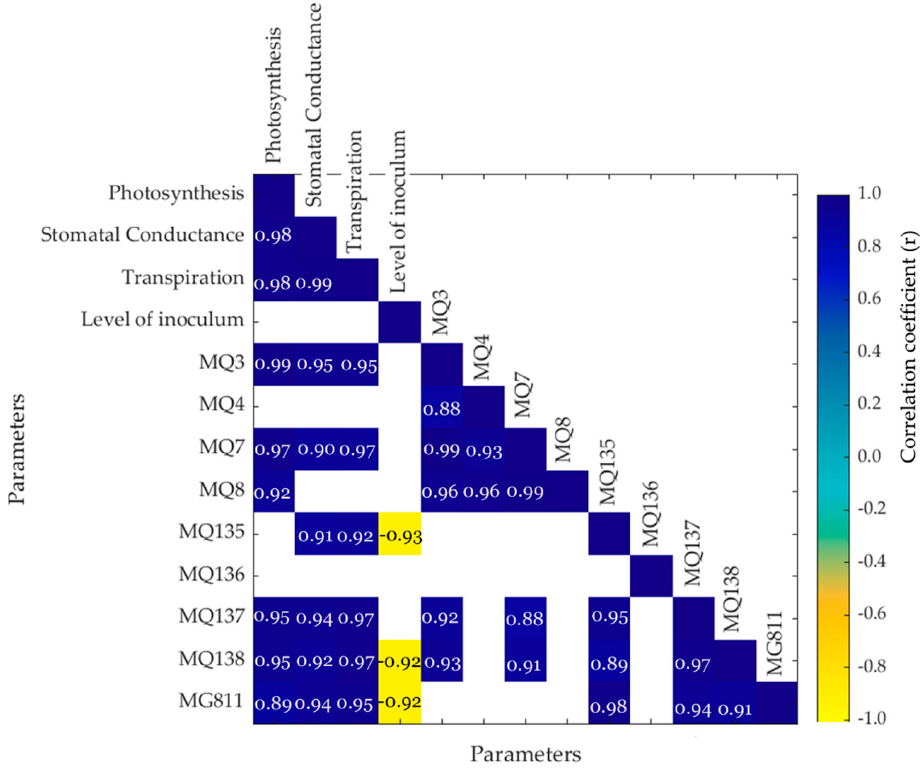
Figure 5. Matrix showing the significant correlations ( p < 0.05) between the physiological data, level of pathogen inoculum, and the electronic nose sensors. The color bar represents the negative (yellow) to positive (blue) correlations, and the numbers within each box are the correlation coefficients (r).